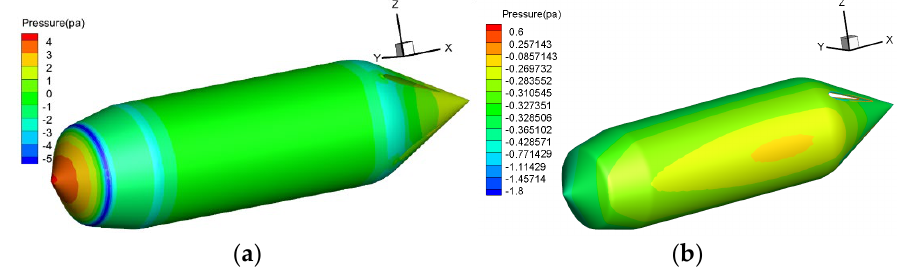
Figure 6. Static pressure of the envelope. ( a ) Forced convection pressure. ( b ) Natural convection pressure.